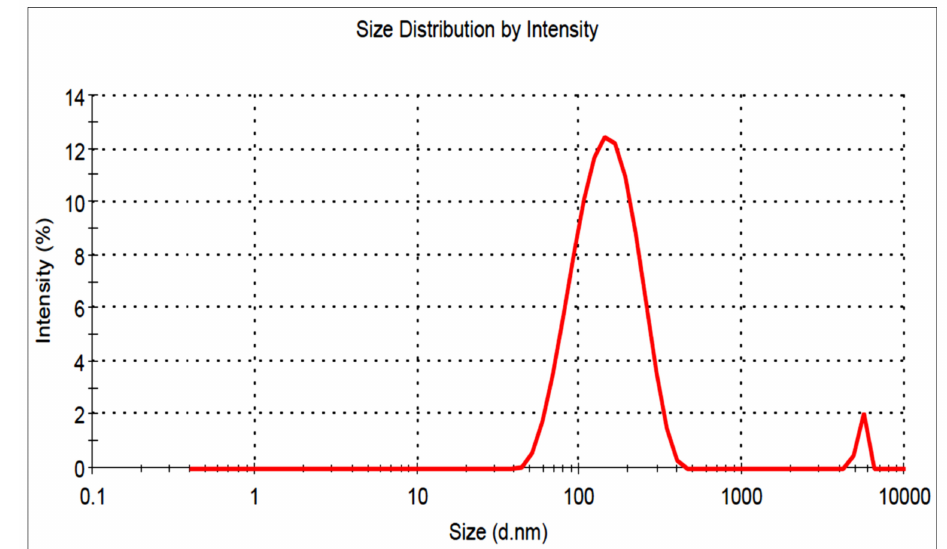
Figure 3. Vesicle size of the optimized miconazole bilosome (MZBSo).